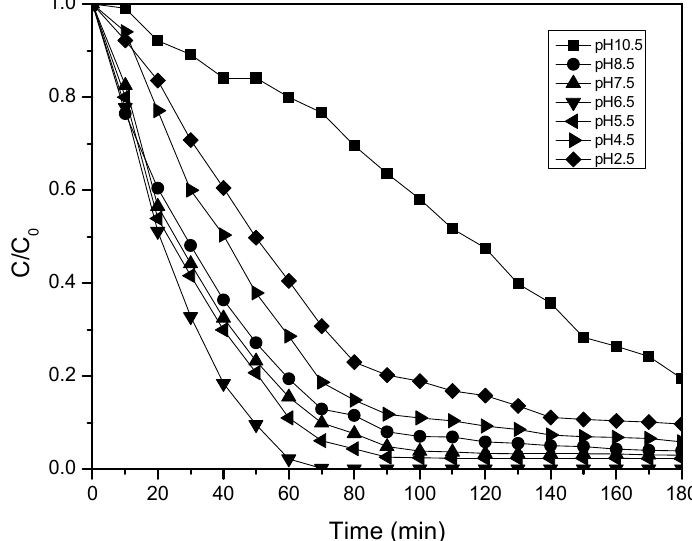
Figure 3. Photocatalytic activity of TiO 2 nanotubes in paracetamol solution at different pHs as function of irradiation time.